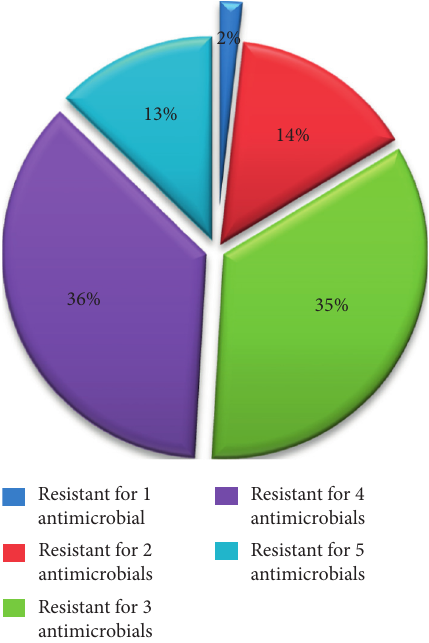
Figure 2: Drug-resistance patterns of S. aureus isolates from the raw beef sample in Bahir Dar city. Table 2: Multiple drug-resistance profile of S. aureus isolates from the raw beef sample in Bahir Dar city. Number of antibiotics showing resistance Number and frequency (%) of resistant isolates Type of